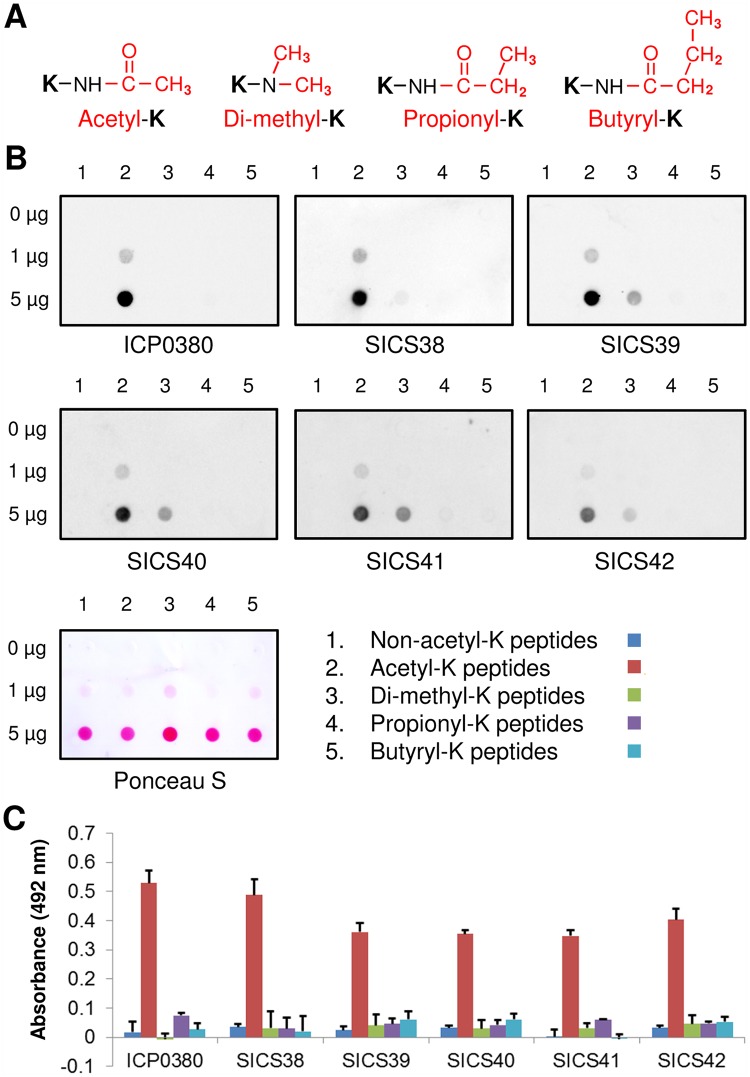
Validation of pan-acK antibodies against other lysine modifications.(A) Chemical structures of acetyl-, di-methyl-, propionyl- and butyryl-lysine. Post-translational modifications were highlighted in red. (B) SICS pan-acK antibodies were tested by a dot blot immunoassay against: (1) wild-type peptides, (2) acetyl-lysine peptides, (3) di-methyl-lysine peptides, (4) propionyl-lysine peptides, and (5) butyryl-lysine peptides. 0, 1, 5 μg of peptides were spotted onto nitrocellulose membrane then detected by commercial pan-acK antibody ICP0380 or SICS pan-acK antibodies. (C) SICS pan-acK antibodies #38 to #42 and the commercial pan-acK antibody ICP0380 were tested by ELISA assay against various lysine modified and un-modified peptide-KLH conjugates.